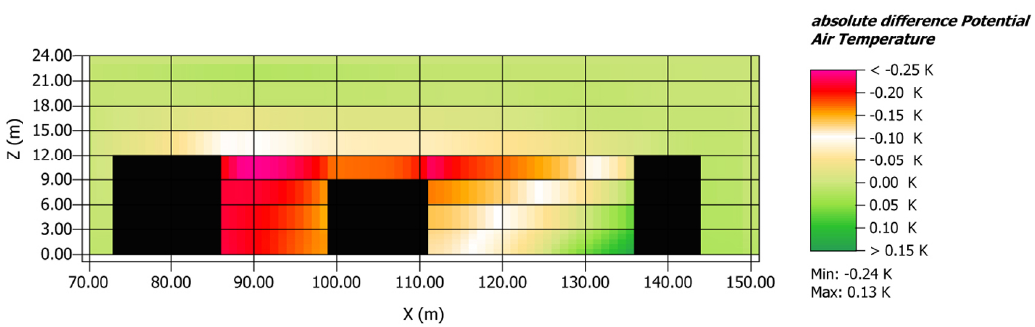
Figure 19. The initial state and creepers roofing scenario air temperature difference in horizontal cross-sections at the height of 1.5 m (figure by authors).